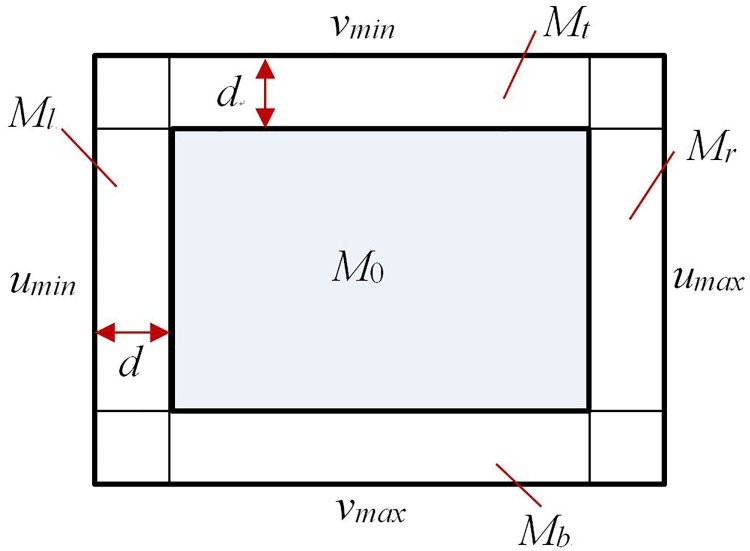
The visual field of the eye-in-hand camera.